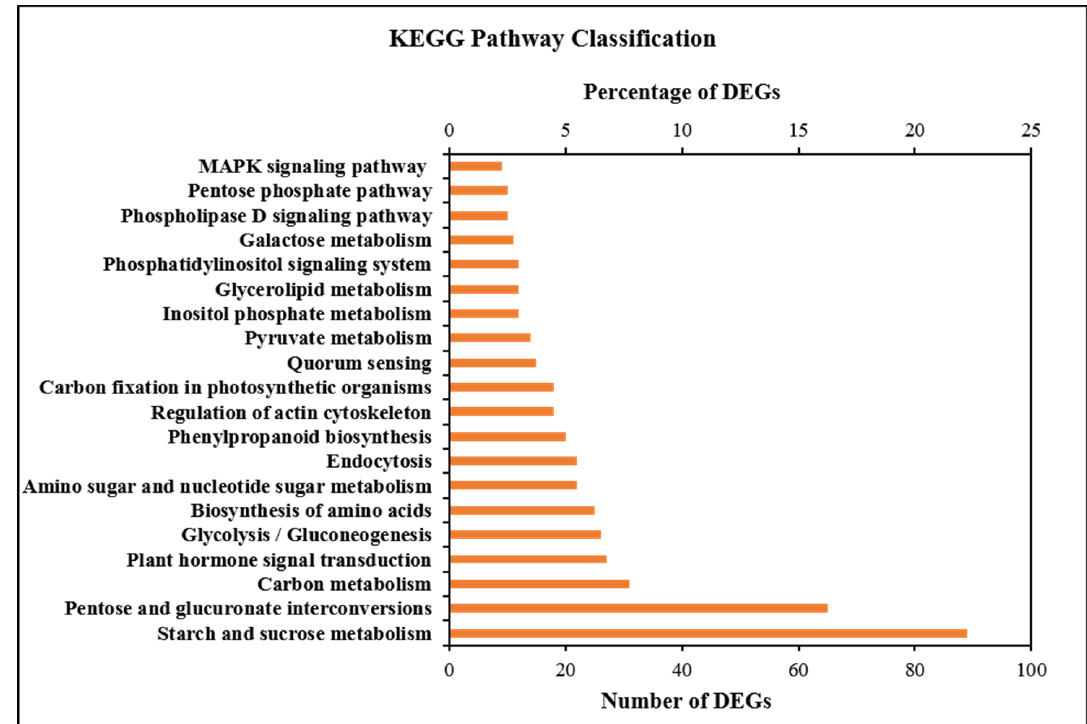
Figure 7. KEGG enrichment analysis of differentially expressed genes (DEGs).